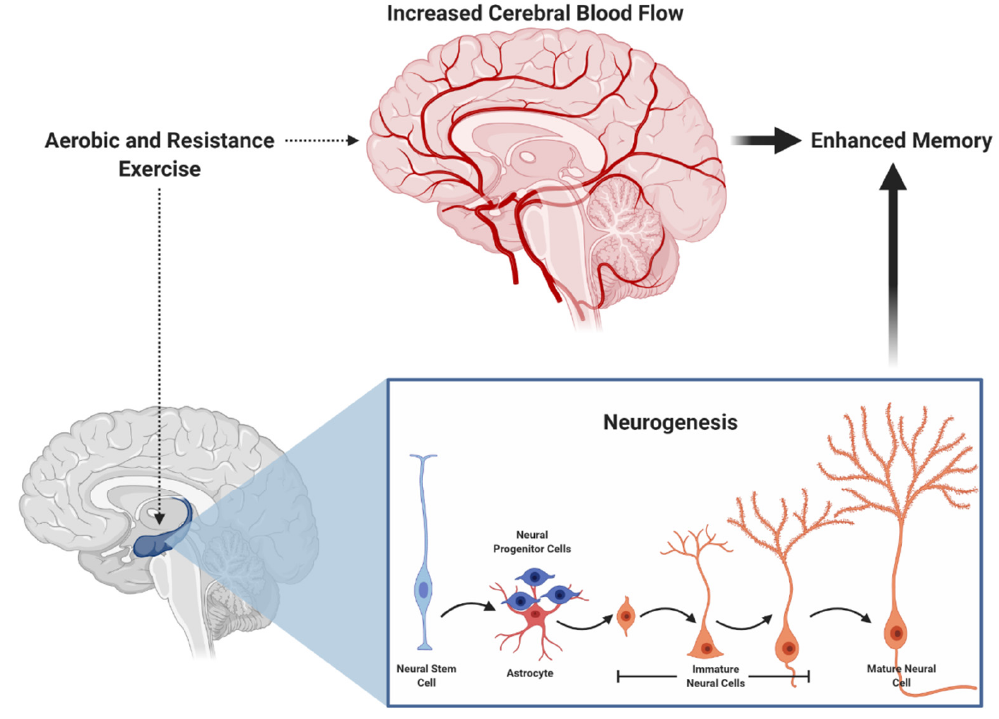
Figure 1. Aerobic and resistance exercise both induce hippocampal neurogenesis and increased cerebral blood, potentially leading to enhanced memory.